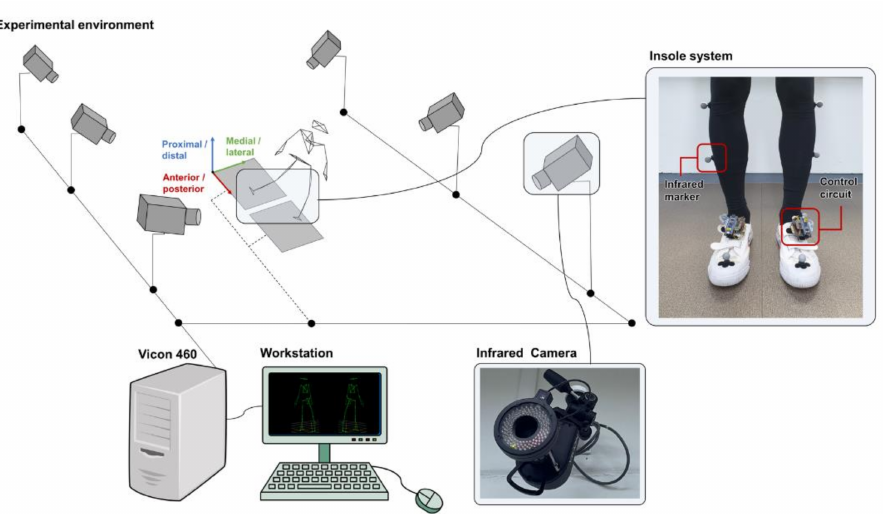
Figure 2. Overview of the experimental environment: infrared cameras receive signals of infrared markers attached to the human body and custom designed insole system placed under the